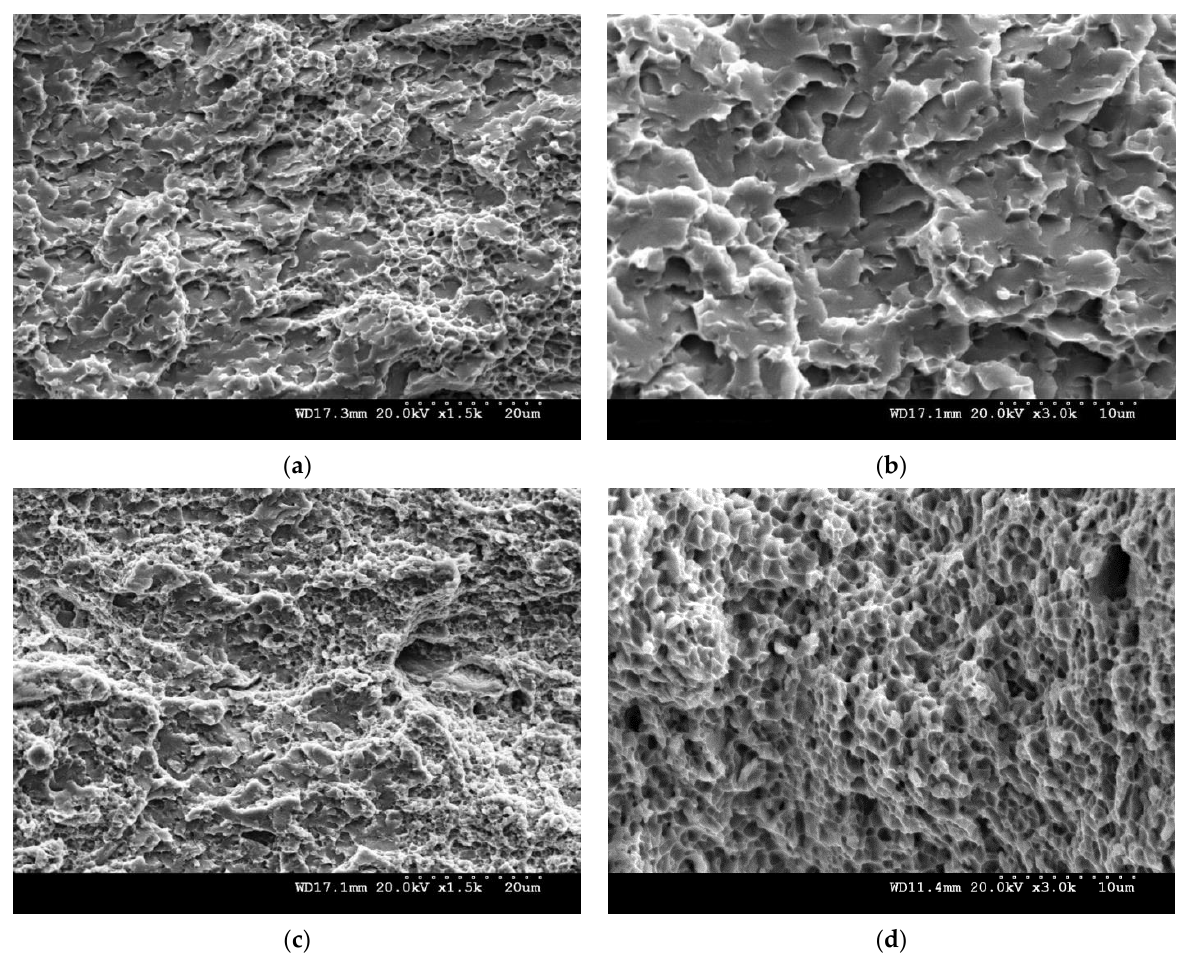
Figure 8. Fracture surfaces of ambient temperature deformed specimens which had been previously warm tested at strain rate 0.001 ( a , b ) and 1 s −1 ( c , d ).